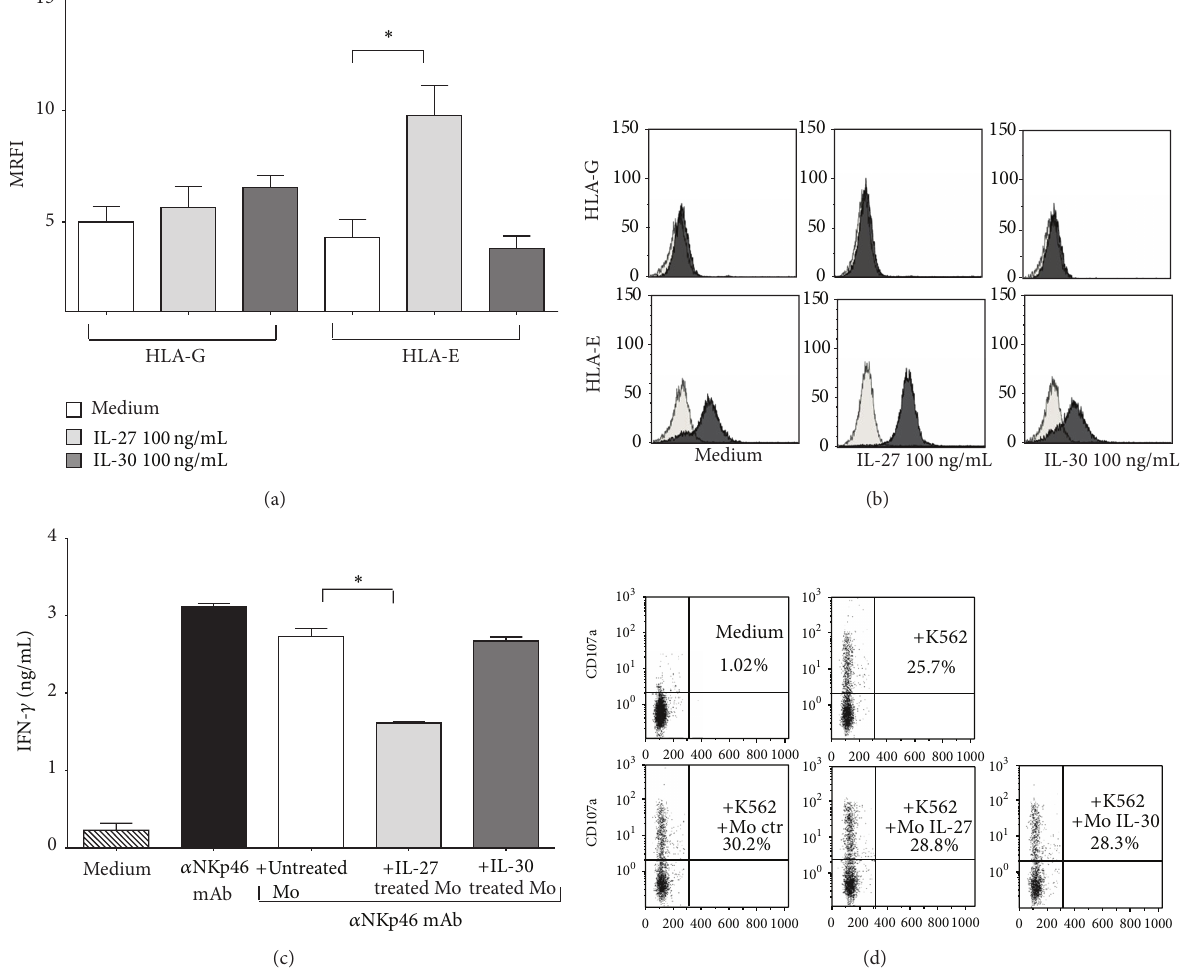
Figure2:ModulationofHLA-GandHLA-EexpressioninhumanmonocytesandfunctionalassaysonNKcells.(a)HLA-Gand-Eexpression was investigated in monocytes cultured with medium alone (white bars), 100 ng/mL IL-27 (light grey bars), or 100ng/mL IL-30 (grey bars). Results are represented as MRFI. Histograms represent mean of six different experiments ± SD. Asterisks indicate statistical significance. One representative FACS analysis is reported in (b). Grey profiles show staining with irrelevant fluorochrome and isotype matched mAb. Black profiles show staining with specific mAb. (c) IFN- 𝛾 was analyzed in supernatants from NK cells cultured with (i) medium alone (stripped bar), (ii) in the presence of coated anti-NKp46 mAb (black bar) or in the presence of coated anti-NKp46 mAb and autologous monocytes, (iii) untreated (white bar), (iv) pretreated with IL-27 (light grey bar), or (v) pretreated with IL-30 (grey bar). Results are represented as ng/mL IFN- 𝛾 . Histograms represent mean of six different experiments ± SD. Asterisks indicate statistical significance. (d) Expression of CD107a was evaluated on NK cells cultured with (i) medium alone, (ii) target cells (K562) at 4 :1 effector :target ratio, and target cells (K562) in the presence of autologous monocytes, (iii) untreated, (iv) pretreated with IL-27, or (v) pretreated with IL-30. One representative experiment out of three performed is shown. The percentage of CD107a + cells (gating on NK cells using physical parameters) is